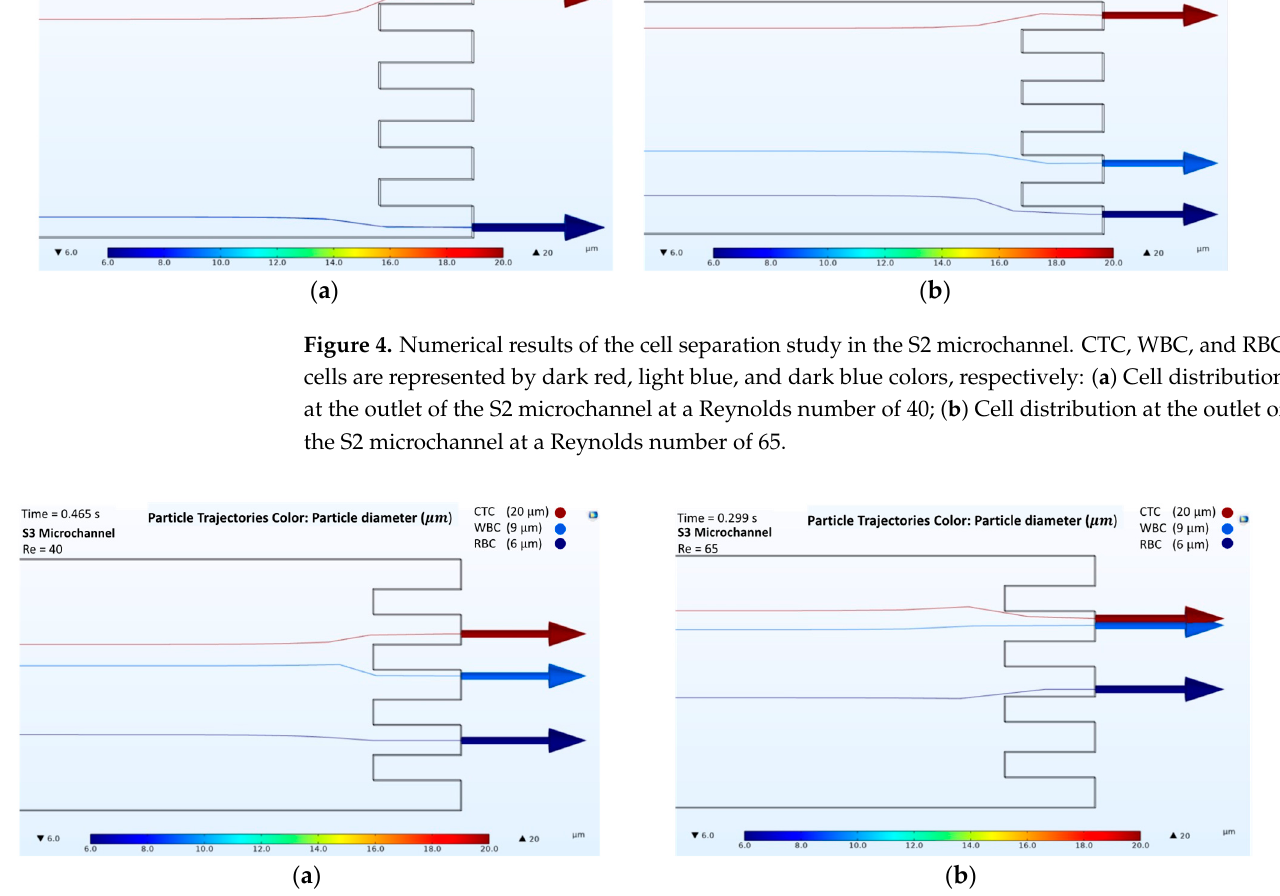
Figure 5. Numerical results of the cell separation study in the S3 microchannel. CTC, WBC, and RBC cells are represented by dark red, light blue, and dark blue colors, respectively: ( a ) Cell distribution at the outlet of the S3 microchannel at a Reynolds number of 40; ( b ) Cell distribution at the outlet of the S3 microchannel at a Reynolds number of 65.